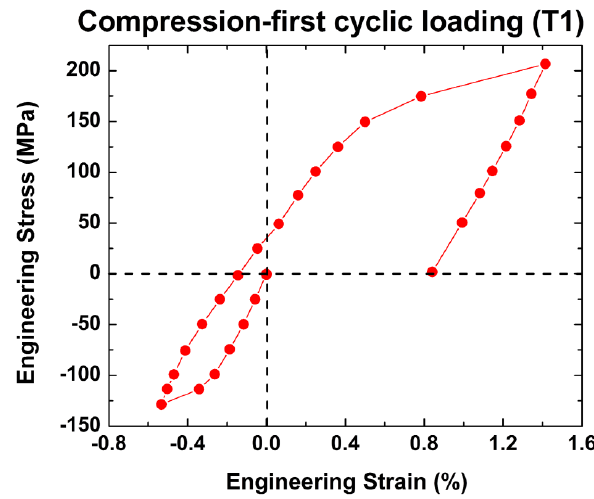
Figure 2. Macroscopic stress-strain response for the T1 sample. The symbols correspond to points in the loading history at which diffraction data were acquired.